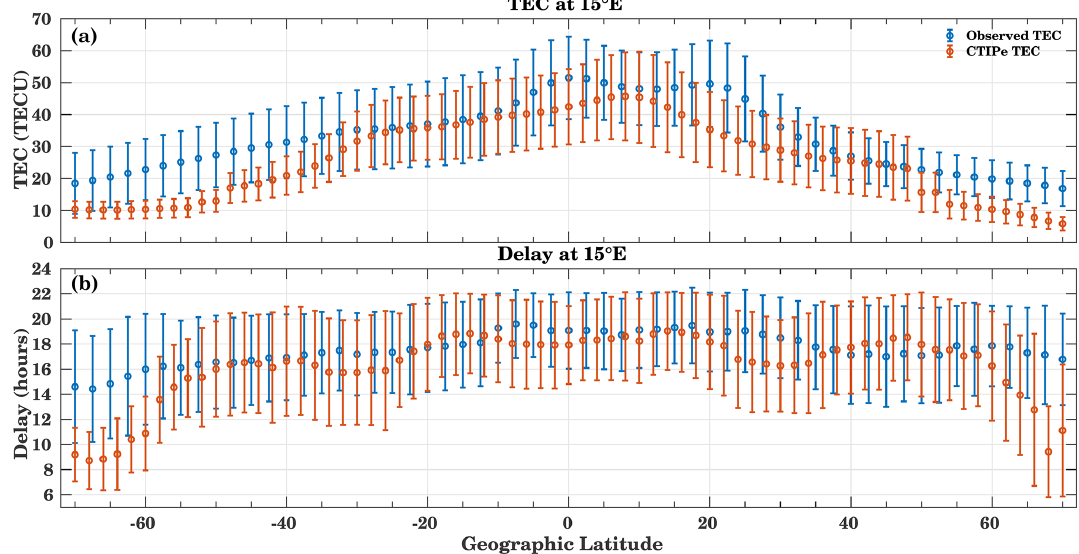
Figure 7. (a) Daily mean TEC variations and (b) delay estimation using observed (blue) and model-simulated (red) hourly TEC and SDO EVE-integrated flux. The error bars show standard deviations of mean